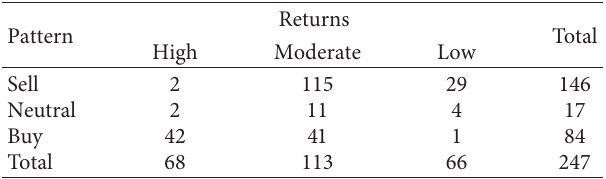
Figure 1: Optimal Band classification for NIFTY 50 of 2010. Table 3: Two-variable classification.